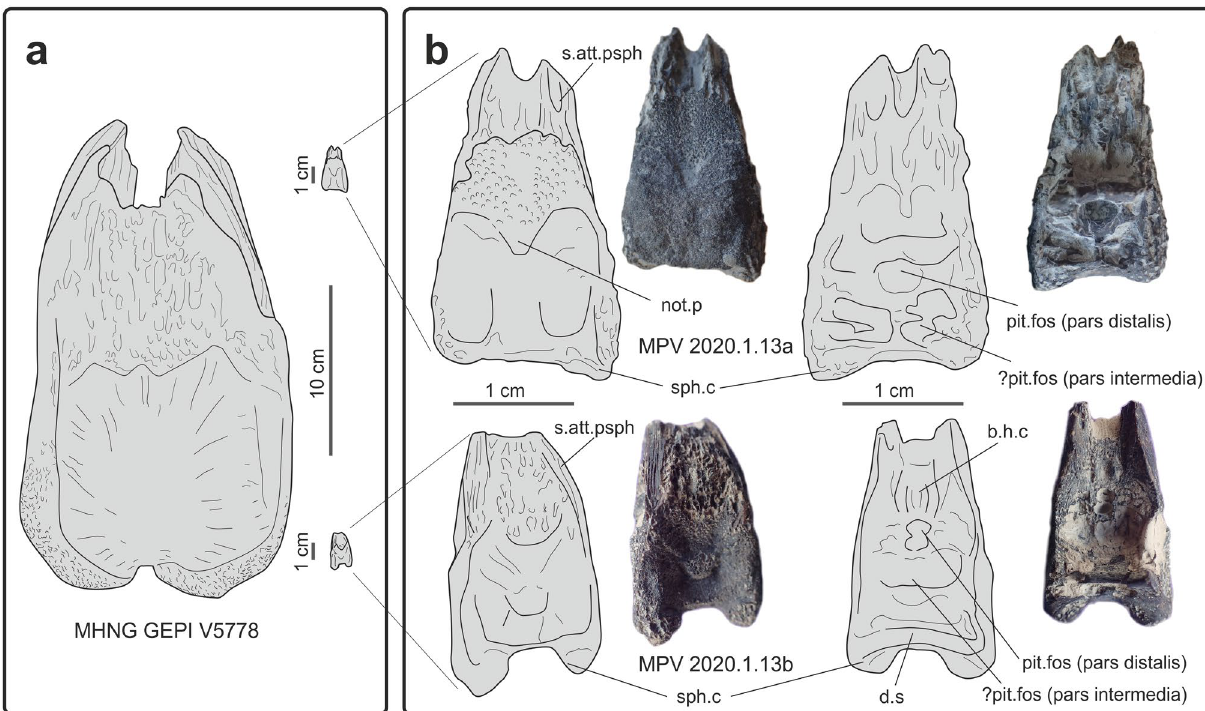
Figure 3. Basisphenoids of embryos or newborns of Trachymetopon sp. from Callovian beds from the Vaches Noires. ( a ) Comparison of the giant specimen (MHNG GEPI V5778) with basisphenoids of potential pups (MPV 2020.1.13); ( b ) details of the basisphenoids of the potential pups (MPV 2020.1.13a and MPV 2020.1.13b) in ventral (left) and dorsal (right) views. Abbreviations: b.h.c, buccohypophysal canal; d.s, dorsum sellae; not.p, notochordal pit; pit.fos, pituitary fossa; s.att.psph, surface of attachment for the parasphenoid; sph.c, sphenoid